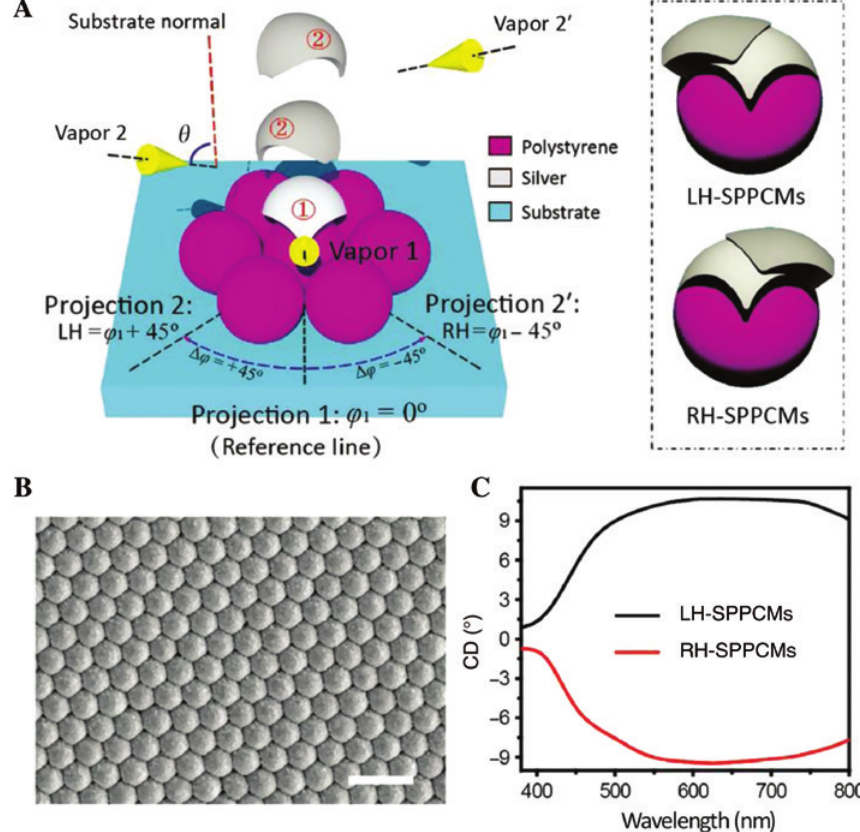
Figure 16: Stacked-patch plasmonic chiral particles. (A) Left: Schematic diagram of two-step GLAD on a self-assembled microsphere monolayer. The black dashed lines labeled with “Projection 1”, “Projection 2”, and “Projection 2 ′ ” are the in-plane projections of the material vapor beams 1, 2, and 2 ′ in the substrate plane, respectively; θ is the deposition angle of the vapor beam with respect to the normal of the substrate (red dashed line); ϕ is the azimuthal angle with respect to the reference direction of the microsphere array (black dashed line labeled by “Reference line” overlapped with “Projection 1”); and ∆ ϕ = ϕ − ϕ is the relative change in azimuthal orientation of the substrate between the first ( ϕ ) and second ( ϕ ) 1 2 1 2 material deposition processes. Right: left-hand (LH) (upper-right) and right-hand (RH) SPPCMs (lower-right) can be prepared, respectively, by two sequential coatings of Ag films following either a clockwise ( ∆ ϕ = + 45 ° ) or anticlockwise ( ∆ ϕ = −45 ° ) direction. (B) Top-view SEM image of a 90 nm-thick LH-SPPCM prepared at θ = 60 ° , ∆ ϕ = + 45 ° . The scale bar in all panels is 1 μ m. (C) Measured CD spectra for an = 0 ° with ∆ ϕ = ± 45 ° , respectively. The deposition thickness of two Ag films is LH- (black) and an RH- (red) SPPCM prepared at θ = 60 ° and ϕ 1 90 nm and the diameter of PS spheres used here is 430 nm, adapted from Ref.